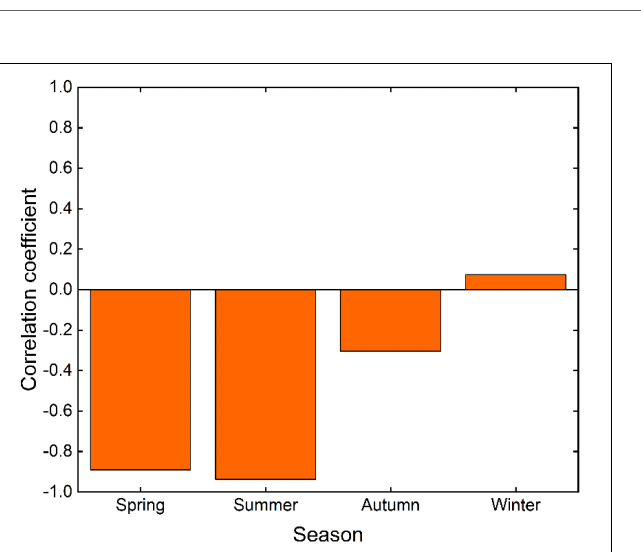
FIGURE 12 | Distribution of correlation coefficients between NDVI and PM10 seasonal changes.